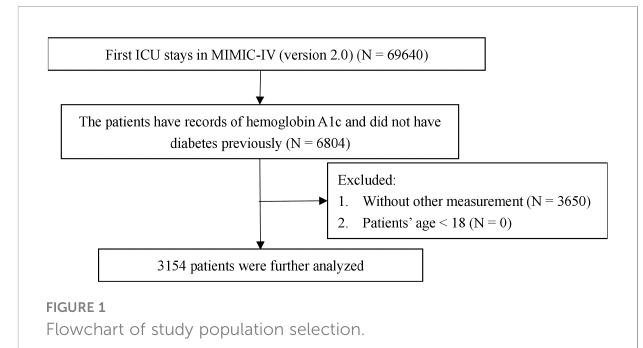
FIGURE 1 Flowchart of study population